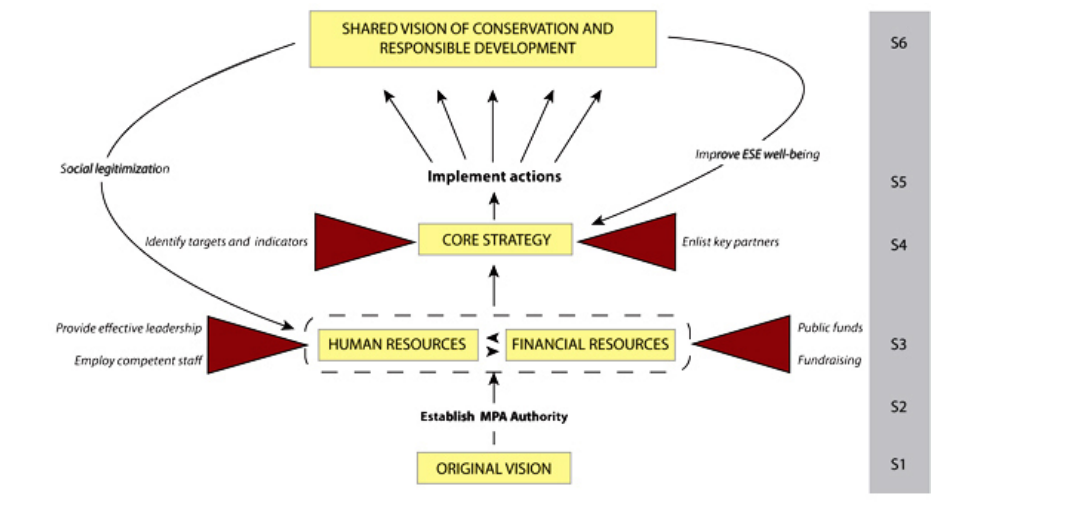
Fig. 4 . Organizational framework for how marine protected area (MPA) authorities can effectively mediate interactions between social, economic, and ecological elements of social-ecological systems, based on key leverages (shown as triangles) (ESE: ecological and socioeconomic). The shaded numbers on the right-hand side refer to the different steps